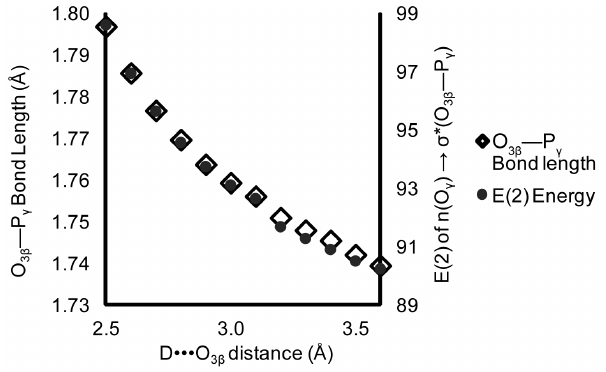
Figure 5. Hyperconjugation in methyl triphosphate, a model for ATP. Electron density is transferred from a lone pair orbital on one of the c -oxygens (O c ), into the antibonding orbital ( s *) of the O 3 b —P c bond. Red lettering indicates the atoms involved in the hyperconjuga- tive interaction and the red arrow represents electron density transfer.